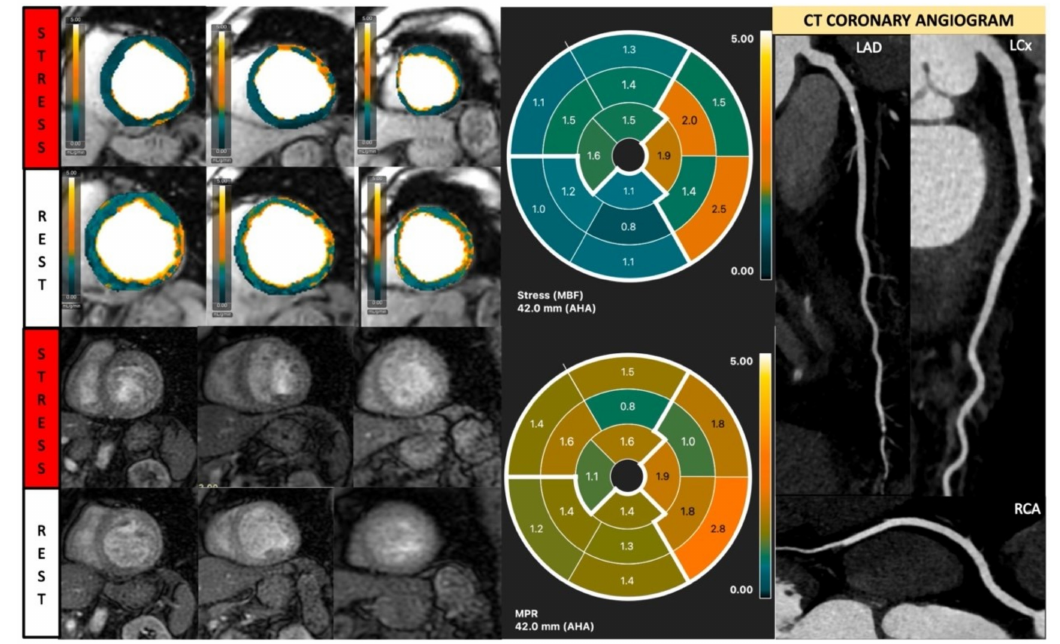
Figure 8. Quantitative stress CMR examination of dilated cardiomyopathy. Female patient in her 60s with dilated cardiomyopathy and phospholamban genetic mutation. Patient underwent stress